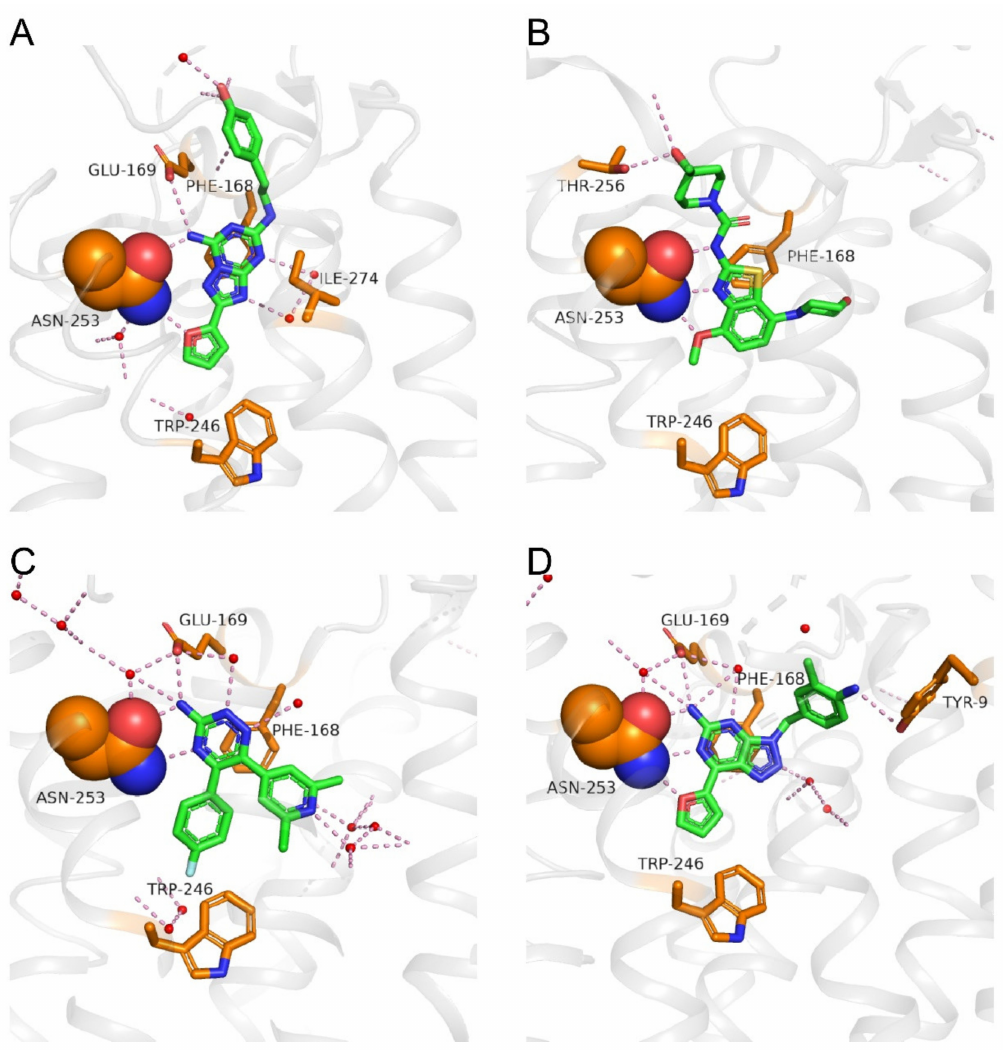
Figure 3. Binding modes of A 2A AR with di ff erent antagonists. ( A ) ZM-241385; the key amino acid residues: Asn253 6.55 , Glu169 5.30 , Phe168 5.29 , Trp246 6.48 , and Ile274 7.39 are identified (PDB ID: 3EML). ( B ) SYN-115; the key amino acid residues: Asn253 6.55 , Thr256 6.58 , Phe168 5.29 , and Trp246 6.48 are identified (PDB ID: 5OLO). ( C ) AZD-4635; the key amino acid residues: Asn253 6.55 , Glu169 5.30 , Phe168 5.29 , and Trp246 6.48 are identified (PDB ID: 6GT3). ( D ) V-2006; the key amino acid residues: Asn253 6.55 , Glu169 5.30 , Tyr9 1.35 , Phe168 5.29 , and Trp246 6.48 are identified (PDB ID: 5OLH). The A 2A AR back bone is colored gray, and the amino acid side chains that interact with the ligands are shown as sticks and colored by element (carbon, yellow; nitrogen, blue; oxygen, red; sulfur, yellow; the side chain of Asn253 6.55 is shown in a space filling presentation). The antagonists are shown as sticks and colored by element (carbon, green; nitrogen, blue; oxygen, red; sulfur, yellow). Polar contacts are presented as dashed lines, and water molecules are shown as red